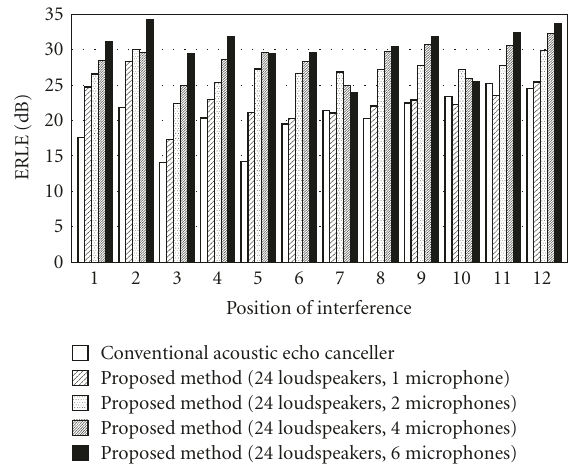
Figure 8: ERLE for each position of interference in 24 loudspeak- ers. The horizontal axis represents the position of interference in Figure 3.